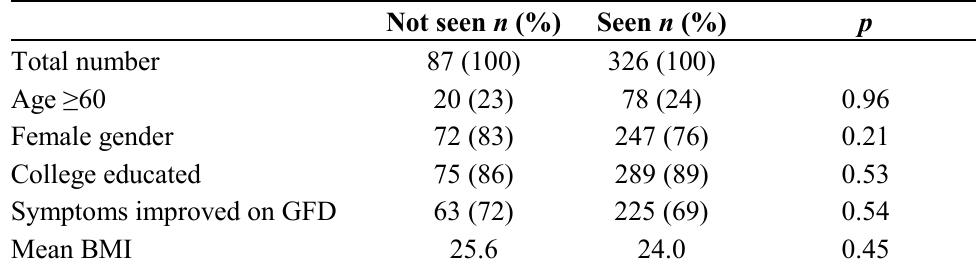
Table 2. Patient characteristics by dietitian use.